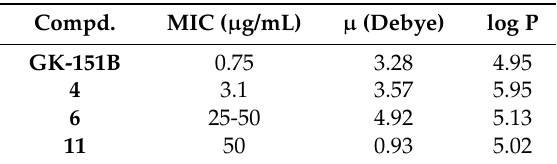
Table 2. Calculated values of absolute energy (E), dipole moment ( µ ) and partition coefficient (log P) of benzimidazoles GK-151B , 4 , 6 , and benzoxazole 11 .